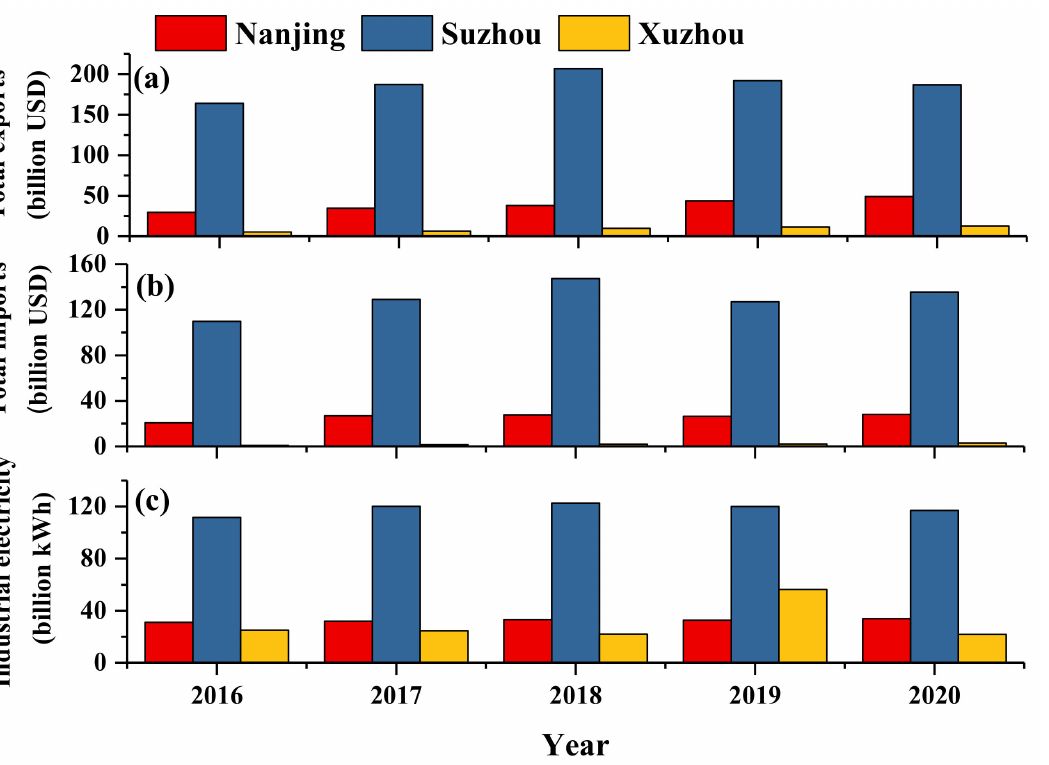
Figure 4. The annual variation of the total exports ( a ), total imports ( b ) and industrial electricity consumption ( c ) of Nanjing, Suzhou and